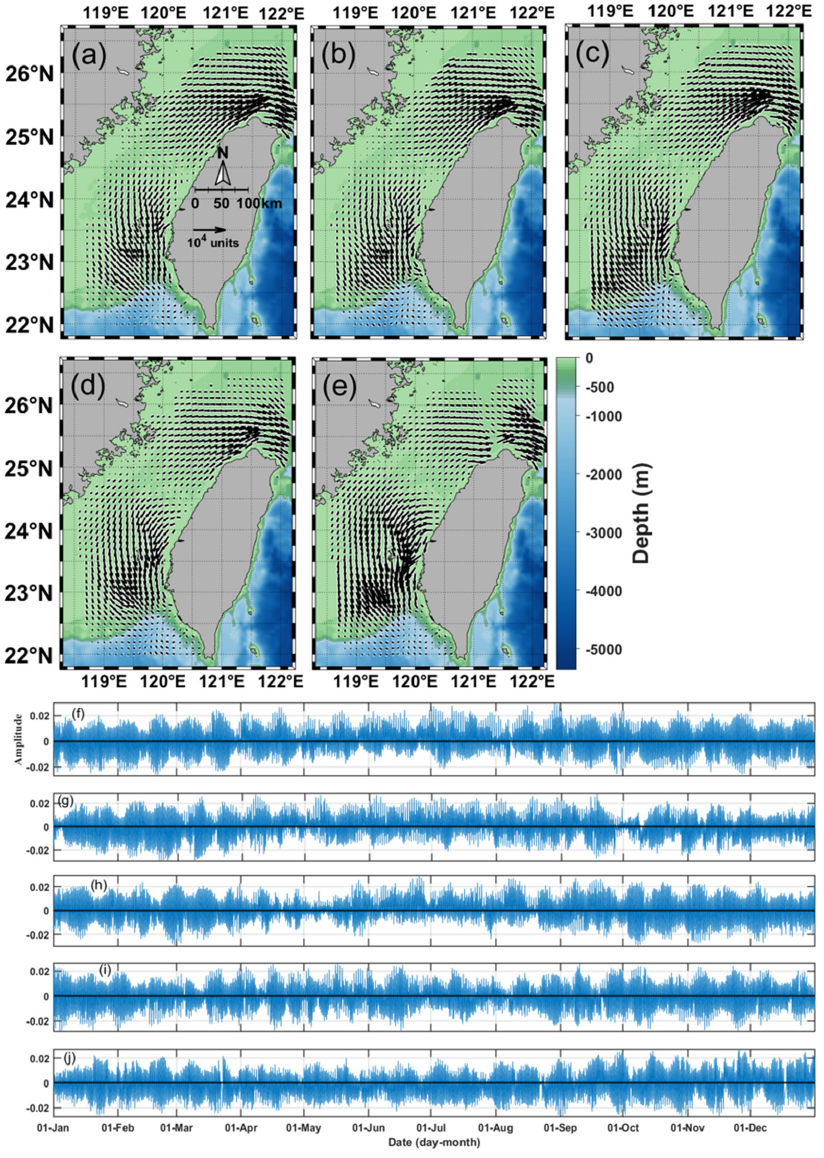
Figure 11. EOF1 results of the Taiwan Strait.